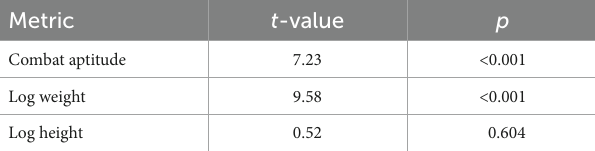
TABLE 7 Results of a multivariate regression analysis examining the relationship between base friendship and combat and size attributes. Metric